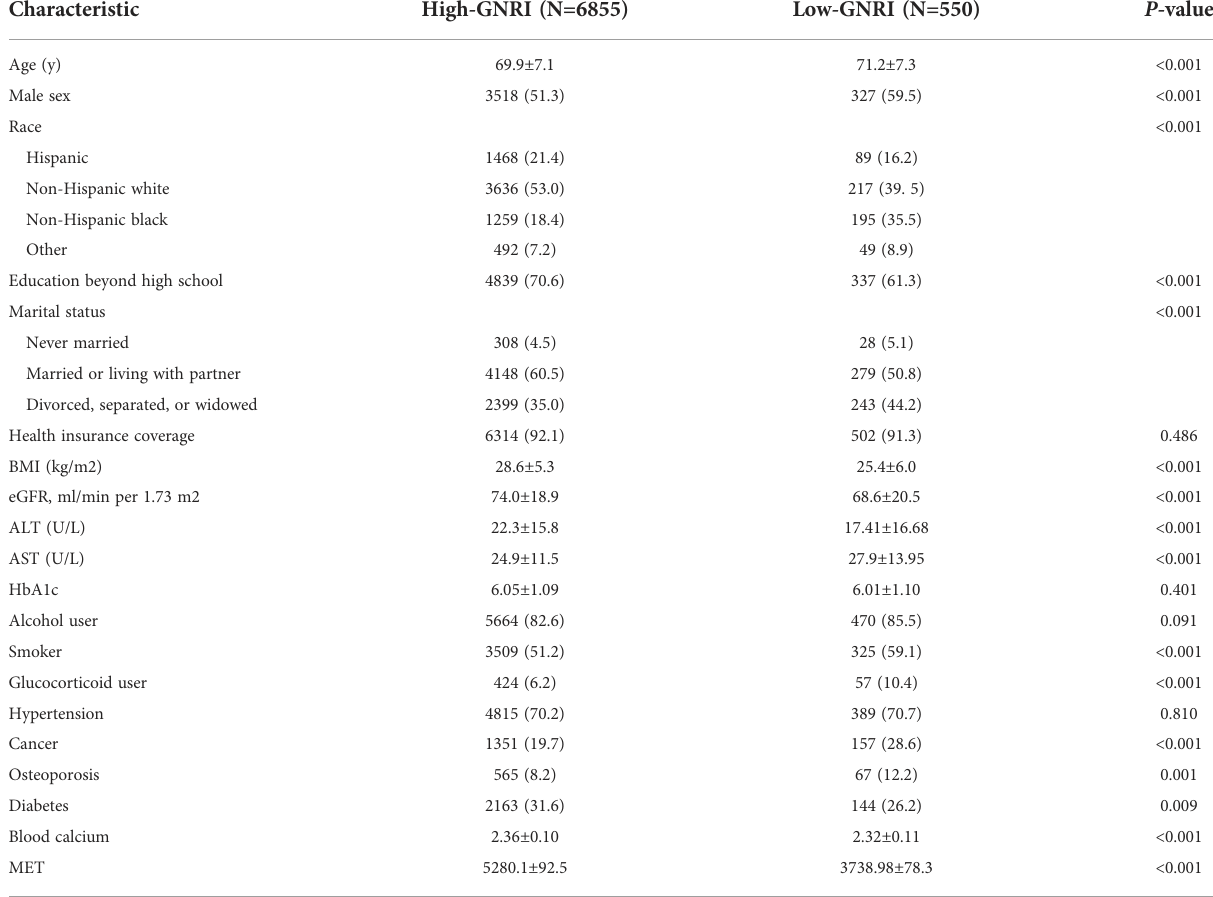
TABLE 1 Characteristics of participants included in study from the NHANES (2005 to